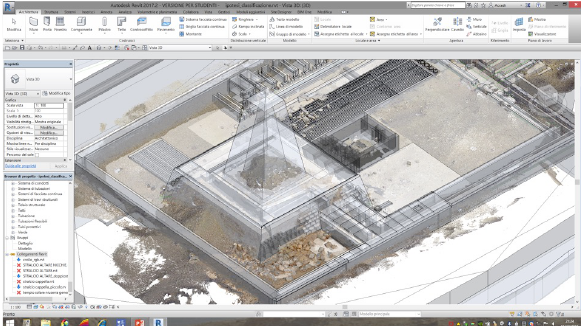
Figure 13: The 3D reconstruction superimposed on the laser scanner survey.